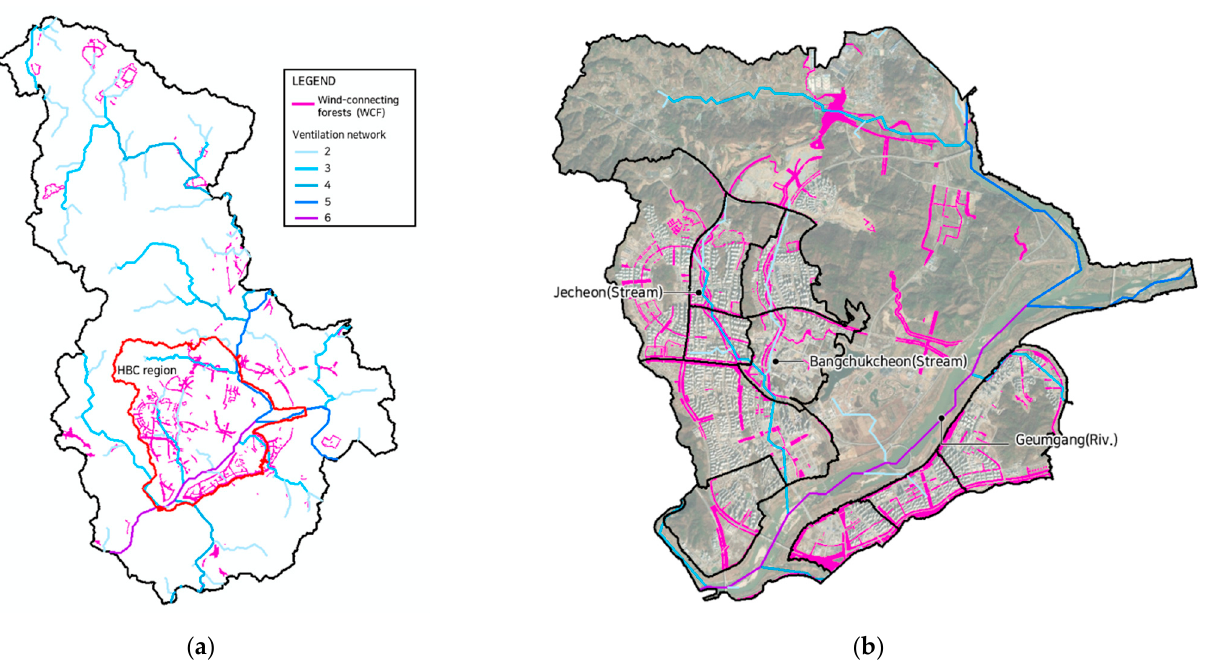
Figure 6. Distribution of wind-connecting forest (WCF) and ventilation network: ( a ) Sejong; ( b ) major areas available for utilizing WCF in HBC region (expressed with satellite image).